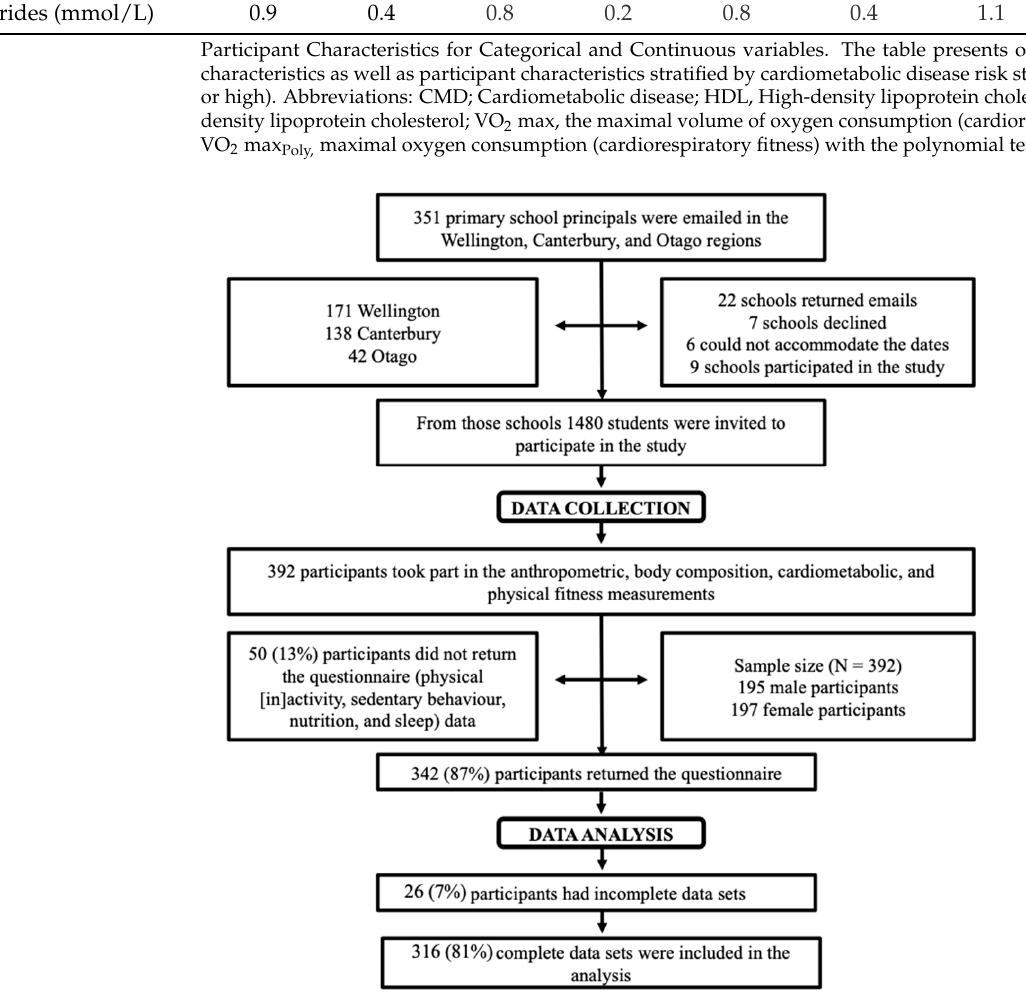
Figure 1. Flow Chart Showing Participant Recruitment and Study Timeline. Includes information regarding the time and location of recruitment, data collection, and analysis. Table 1. ( a ) Overall and Risk Stratified Participant Characteristics for Categorical Variables. ( b ) Overall and Risk Stratified Participant Characteristics for Continuous Variables. ( a )